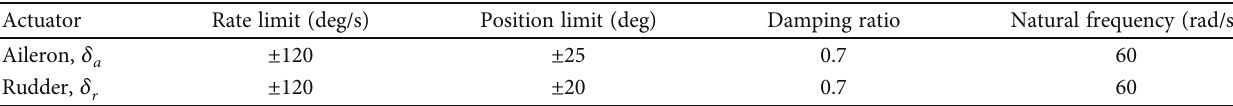
Figure 12: Lateral – directional ESO-based control Table 4: Characteristics of the control e ff ectors.